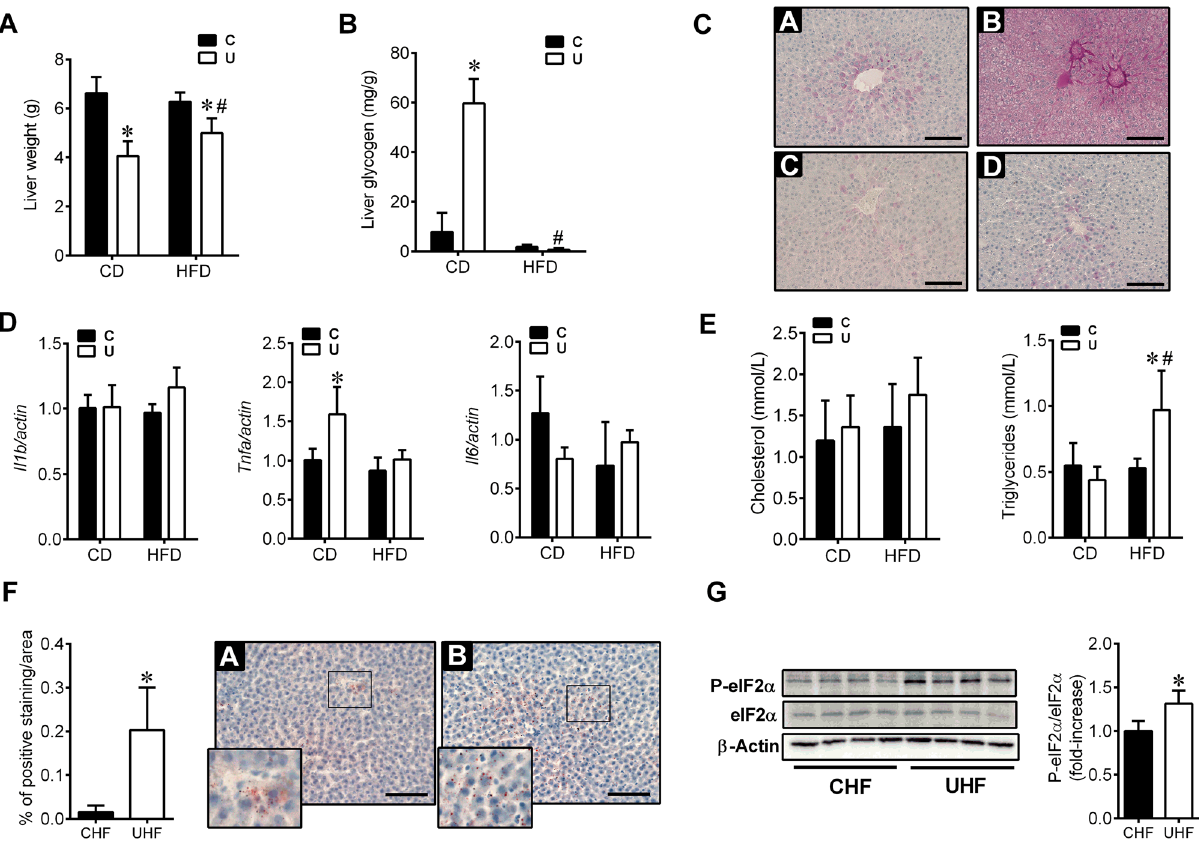
Figure 8. High-fat diet-induced hepatic lipid accumulation leads to activation of the ER stress marker eIF2α in U adult rats. ( A ) Liver weight of control (C) and undernourished (U) adult rats fed with chow-diet (CD) or high-fat diet (HFD) for 22 weeks, n = 10–12. ( B ) Glycogen content in livers (n = 5–6) and ( C ) periodic acid- Schiff (PAS) staining of liver sections from C and U adult rats fed with CD or HFD (n = 2) (scale bar, 100 μm). ( D ) Quantitative RT-PCR analysis of Il1b , Tnfa and Il6 expression on adult rat livers of different diet groups normalised for actin (n = 5–6). (E) Cholesterol and triglycerides circulating levels (mmol/L) in C and U rats fed with chow-diet (CD) or high-fat diet (HFD) for 22 weeks (n = 12). ( F ) Representative images of Oil Red O staining and quantification of hepatic-specific lipid content in C and U rats fed with HFD for 22 weeks (CHF and UHF) (n = 3) (scale bar, 100 μm). ( G ) Representative blots of 2 independent experiments (n = 8) of the protein levels of phosphorylated and total eIF2α in liver homogenates from CHF and UHF animals. Bars represent densitometric quantification of all blots relative to β-actin protein levels. All values are mean ± SD. * p < 0.05 within the same type of diet (U vs. C; UHF vs. CHF); # p < 0.05 between different diet groups (CHF vs. C; UHF vs.